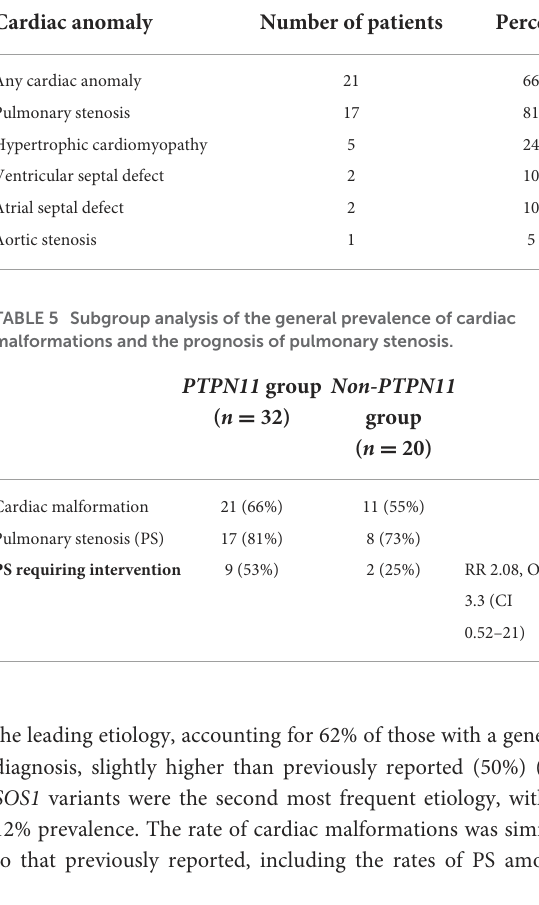
TABLE 4 Cardiac anomalies in 32 patients with Noonan syndrome, diagnosed with PTPN11 variants.